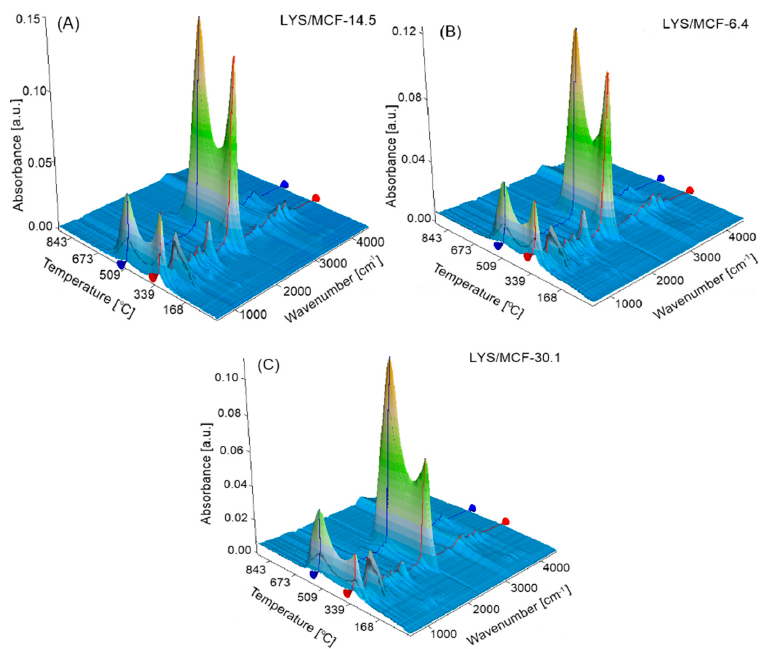
Figure 5. 3D FTIR spectrum of ( A ) LYS / MCF-14.5, ( B ) LYS / MCF-6.4, and ( C ) LYSMCF-30.1 composites registered at two peaks temperatures T peak1 (red line) and T peak2 (blue line) marked from DSC curves.